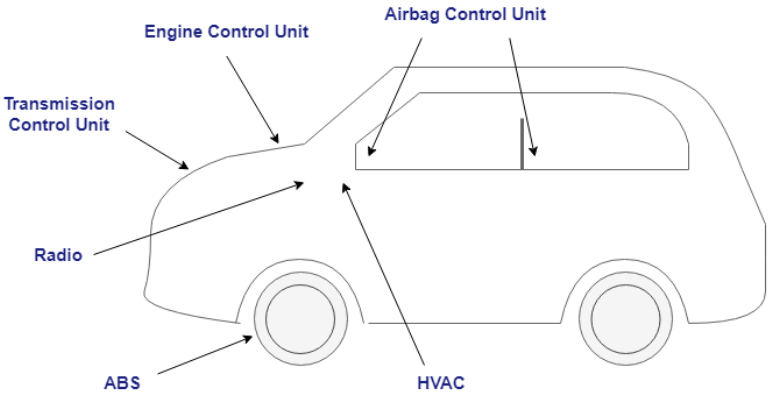
Figure 6. Attack surfaces used in a potential cyber